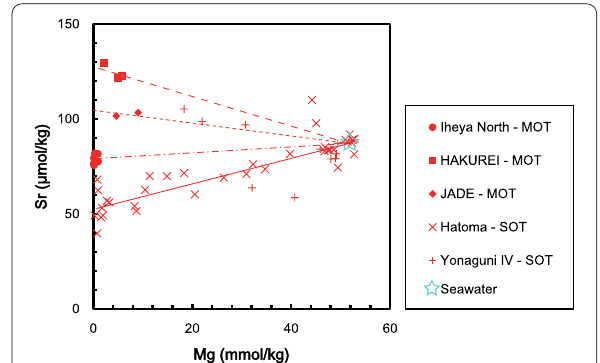
Fig. 2 Relationship between Mg and Sr concentrations in hydrothermal fluids from the Iheya North Knoll, HAKUREI, JADE, Hatoma Knoll, and Yonaguni Knoll IV sites in the Okinawa Trough. Light blue stars indicate the value of seawater. Red lines are regression lines through all data and seawater for each site. No such line was drawn for the Yonaguni Knoll IV because of poor fit